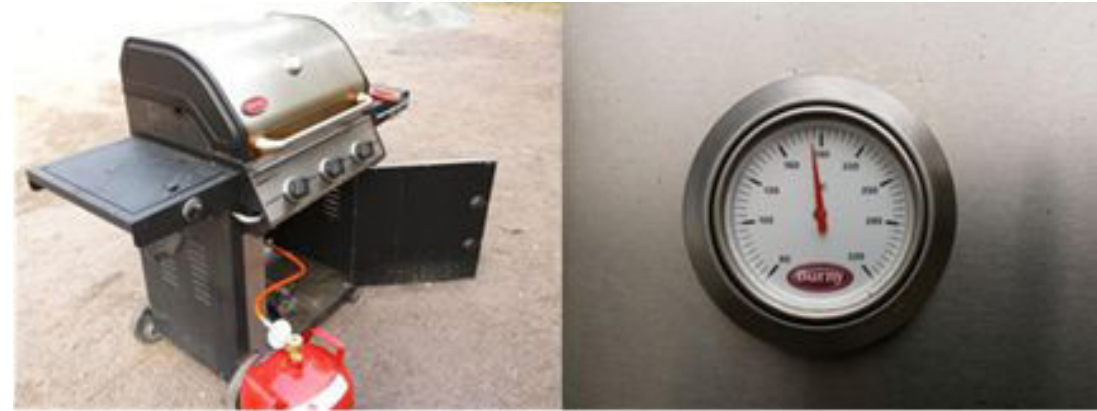
Figure 1. Heat source used for sensory